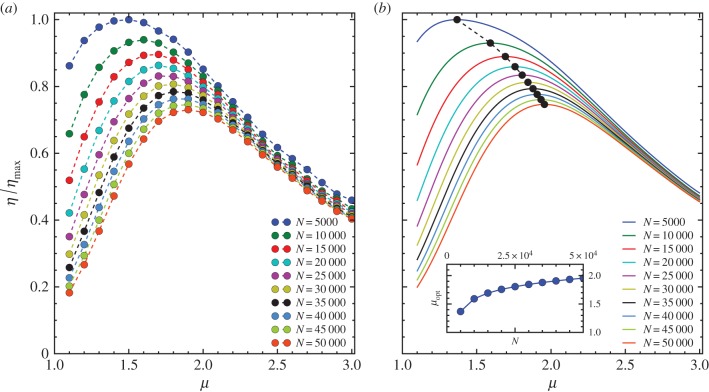
(a) The rescaled search efficiency η/ηmax versus the power-law exponent μ for different values of the total number of steps N from numerical simulation with the intensity of stochastic returning β = 0, the landscape size L = 1000, the number of targets K = 5000 and the termination condition Θn = δ(n − N). The results are averaged over 100 realizations. The rescaling factor ηmax = η(μ = μopt, N = 5000) is the overall maximum search efficiency. (b) η/ηmax versus μ from mean-field calculation. The black dots indicate the peaks of the curves. The inset of panel (b) shows μopt versus N. The curves in panels (a,b) with different colours from top to bottom correspond to various N ∈ [5 × 103, 5 × 104] with an interval of 5000. Note that the discrepancy between the simulation and the mean-field approach here is mostly due to the slight deviation of equation (3.4), as shown in figure 7b. This can be improved by better calibrating the form of equation (3.4), e.g. using curve fitting as we obtain the form of continuous function for nd(μ) and γ(μ).